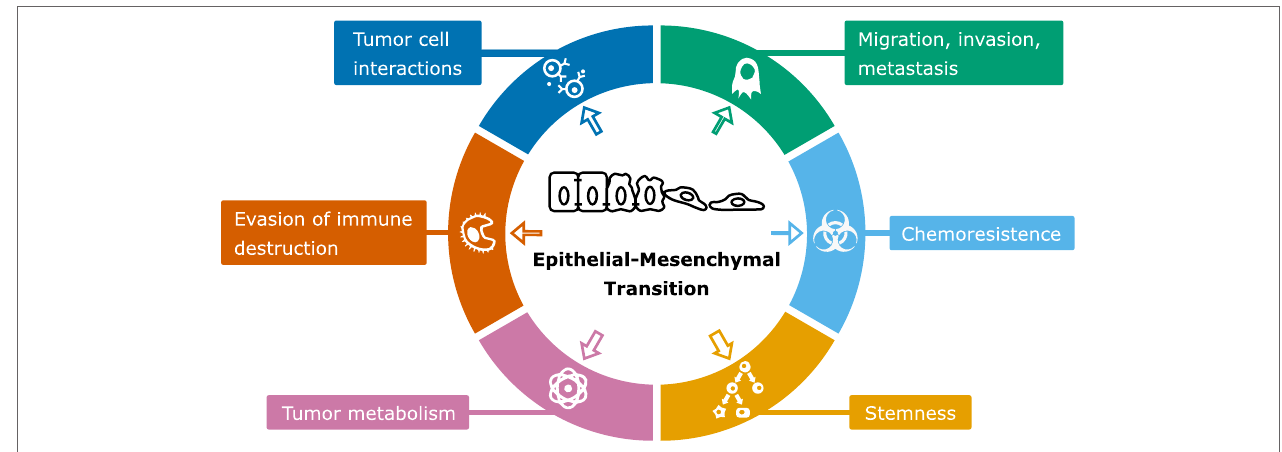
FiGURe 4 | Scheme of epithelial–mesenchymal transition (EMT) and associated cancer characteristics. The size of the arrows indicates the amount of modeling studies focused on the association of EMT with the particular cancer characteristic [based on by Ref.